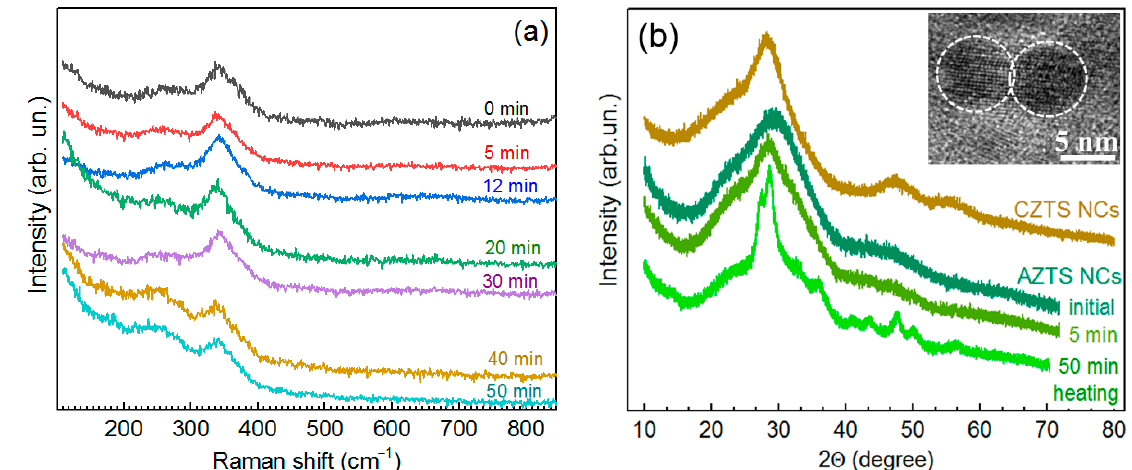
Figure 2. ( a ) Raman spectra of AZTS NCs heated in the solution at 96–98 ° C for different times (0 to 50 min). ( b ) XRD pattern of the CZTS and AZTS NCs and AZTS NCs subject to heating in the solution for 5 and 50 min. The inset in (b) shows a representative TEM image of as-synthesized AZTS NCs (i.e., not subject to heating).